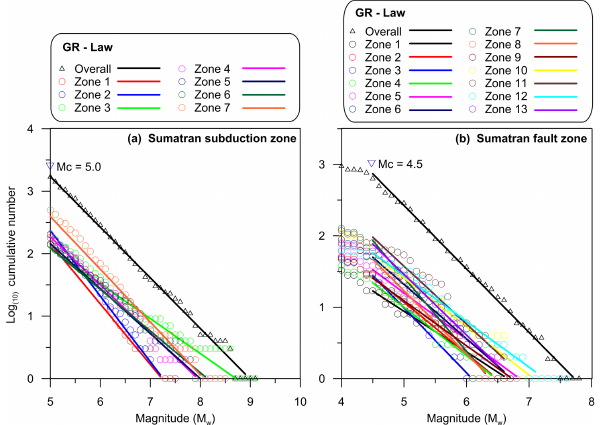
Figure 6. Magnitude vs. cumulative number relation obtained using the Gutenburg–Richter Law (GR-Law) for the (a) Sumatran sub- duction zone and the (b) Sumatran fault zone. The b values are listed in Table